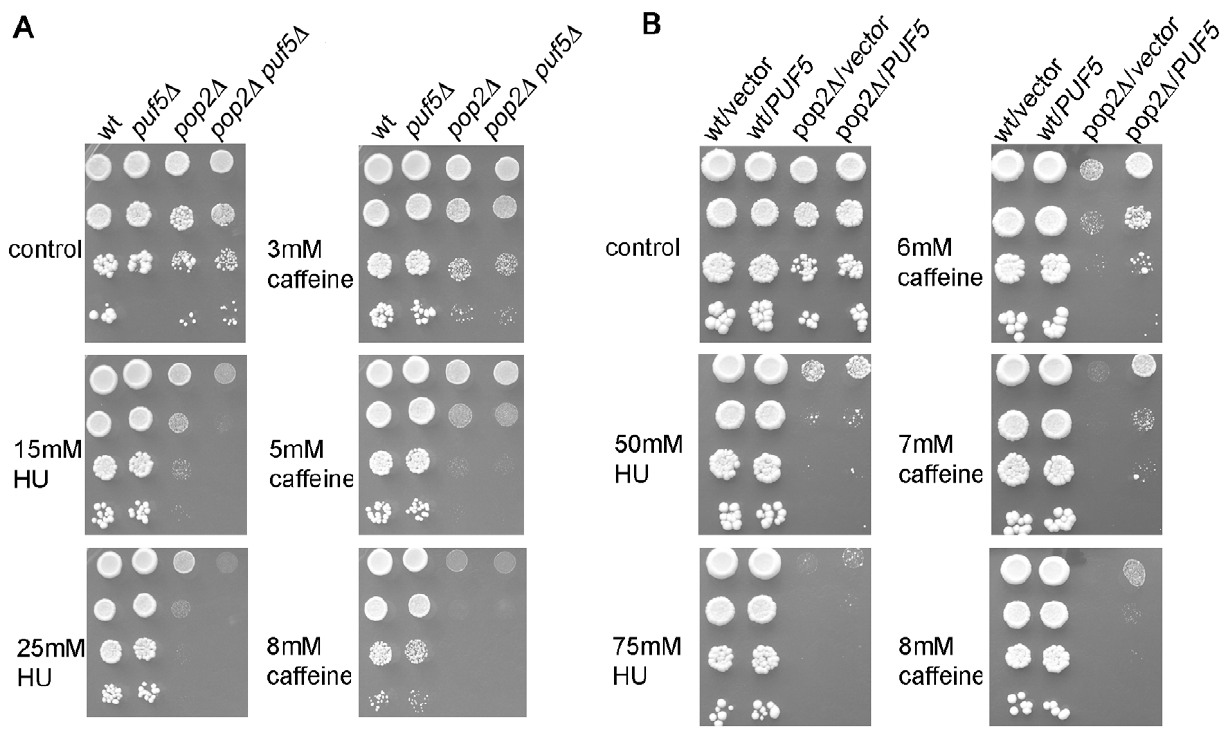
Figure 4. POP2 and PUF5 act in the same genetic pathway in response to caffeine. A) Cells of the indicated strains were dropped on plates with or without caffeine and incubated for 2–3 days at 30 u C. B) wt or pop2 D mutants (strain YAT179 in Table 1) were transformed with vector only (pRS426) or a 2 m plasmid expressing Puf5 (pMPT5, 19). Cells were dropped on YPD plates with or without HU and caffeine and the indicated doses and photographed after five days at 30 u C. Similar results were obtained on 2 Ura selective plates (Figure